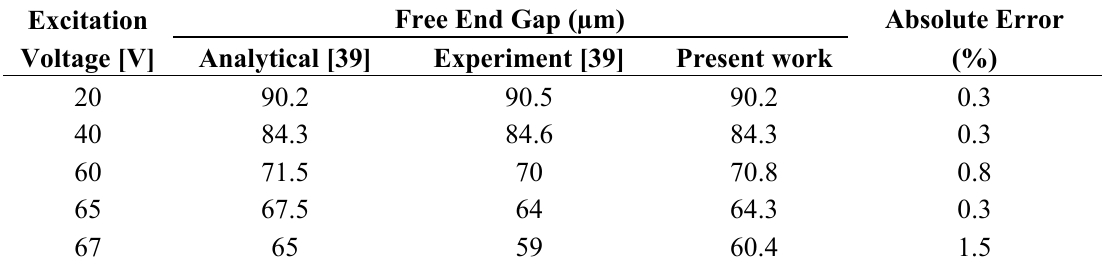
Table 1. Comparison between analytical and experimental and the present work for microcantilevers deformation under electrostatic